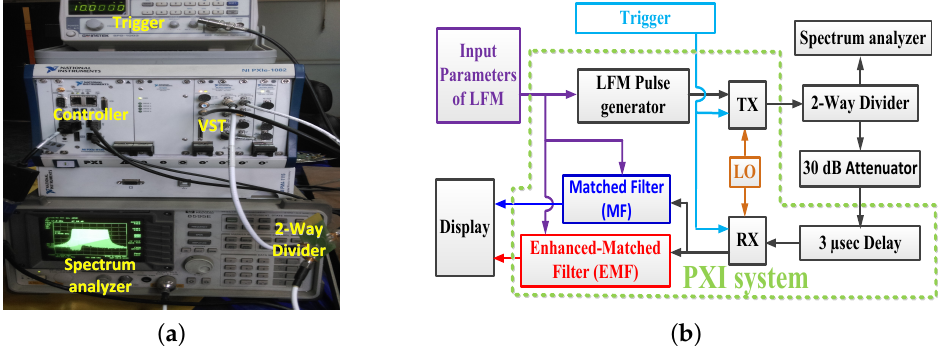
Figure 20. Experimental work in the laboratory: ( a ) Setup of the experiment. ( b ) Block diagram of experimental